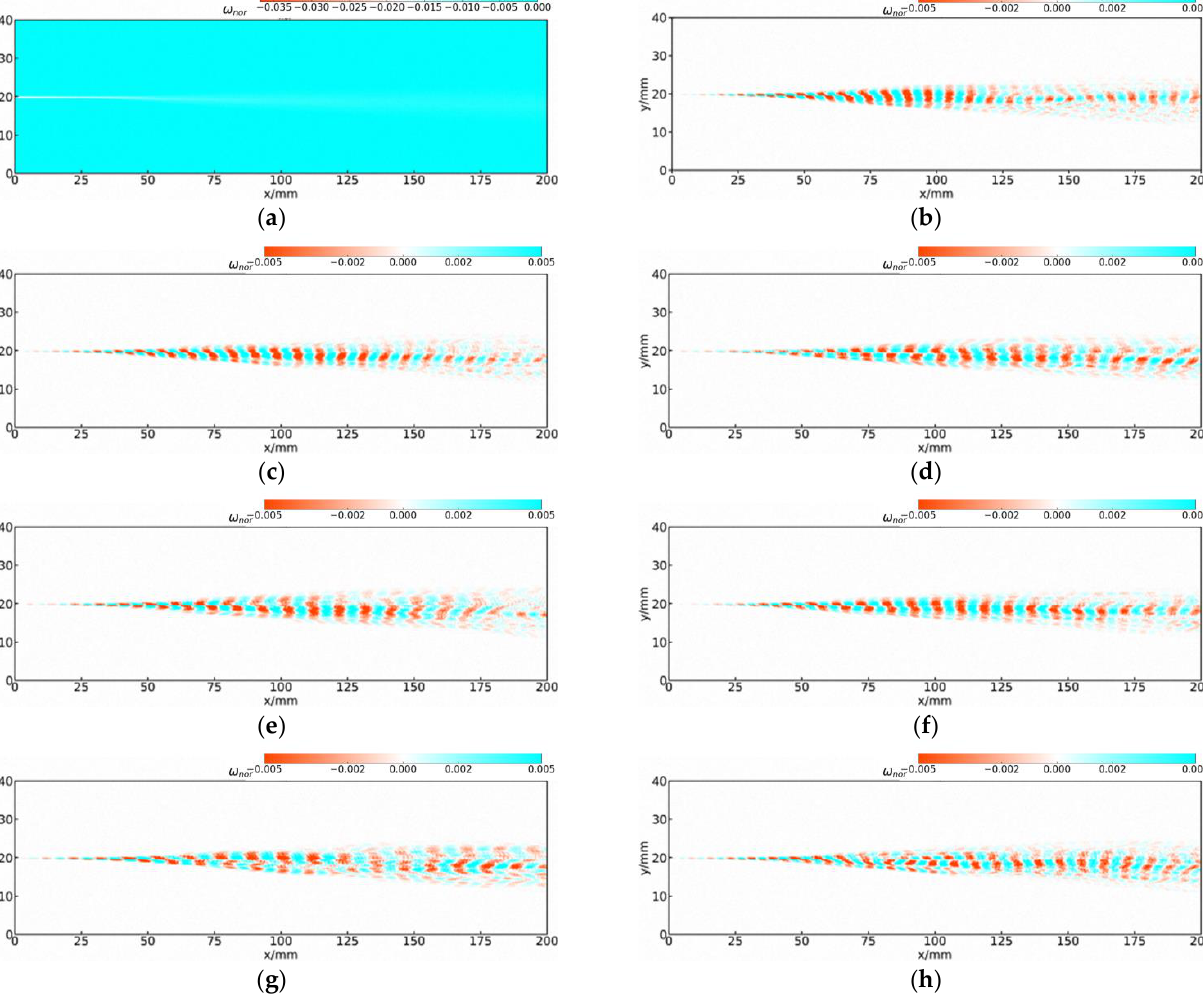
Figure 15. Dimensionless vorticity contour of the first eight modes in Case 1: ( a ) the 1th mode; ( b ) the 2nd mode; ( c ) the 3rd mode; ( d ) the 4th mode; ( e ) the 5th mode; ( f ) the 6th mode; ( g ) the 7th mode; ( h ) the 8th mode.